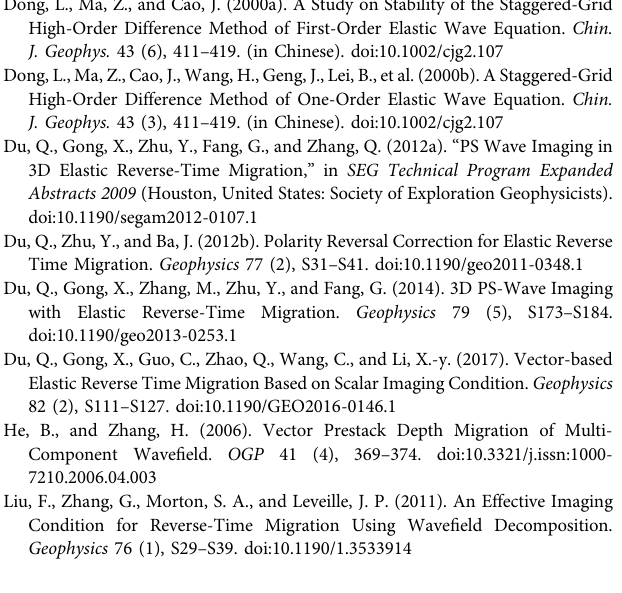
TABLE 1 | Comparison of the migration computational ef fi ciency of the one-shot between the velocity-stress equations and velocity-dilatation-rotation equations. Addition and